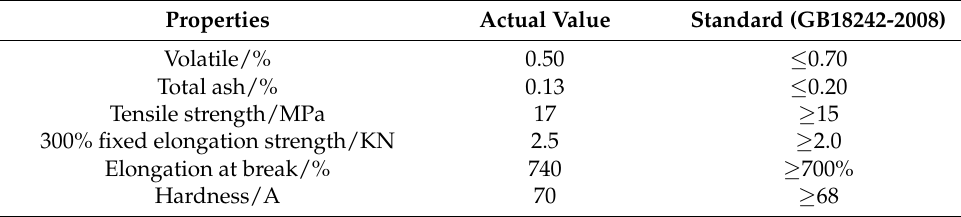
Table 2. Properties of SBS.